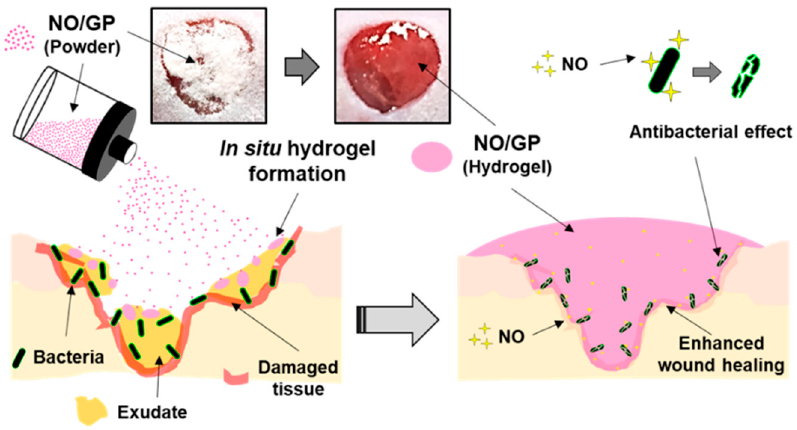
Figure 9. Schematic illustration of NO/GP for the treatment of infected wounds.